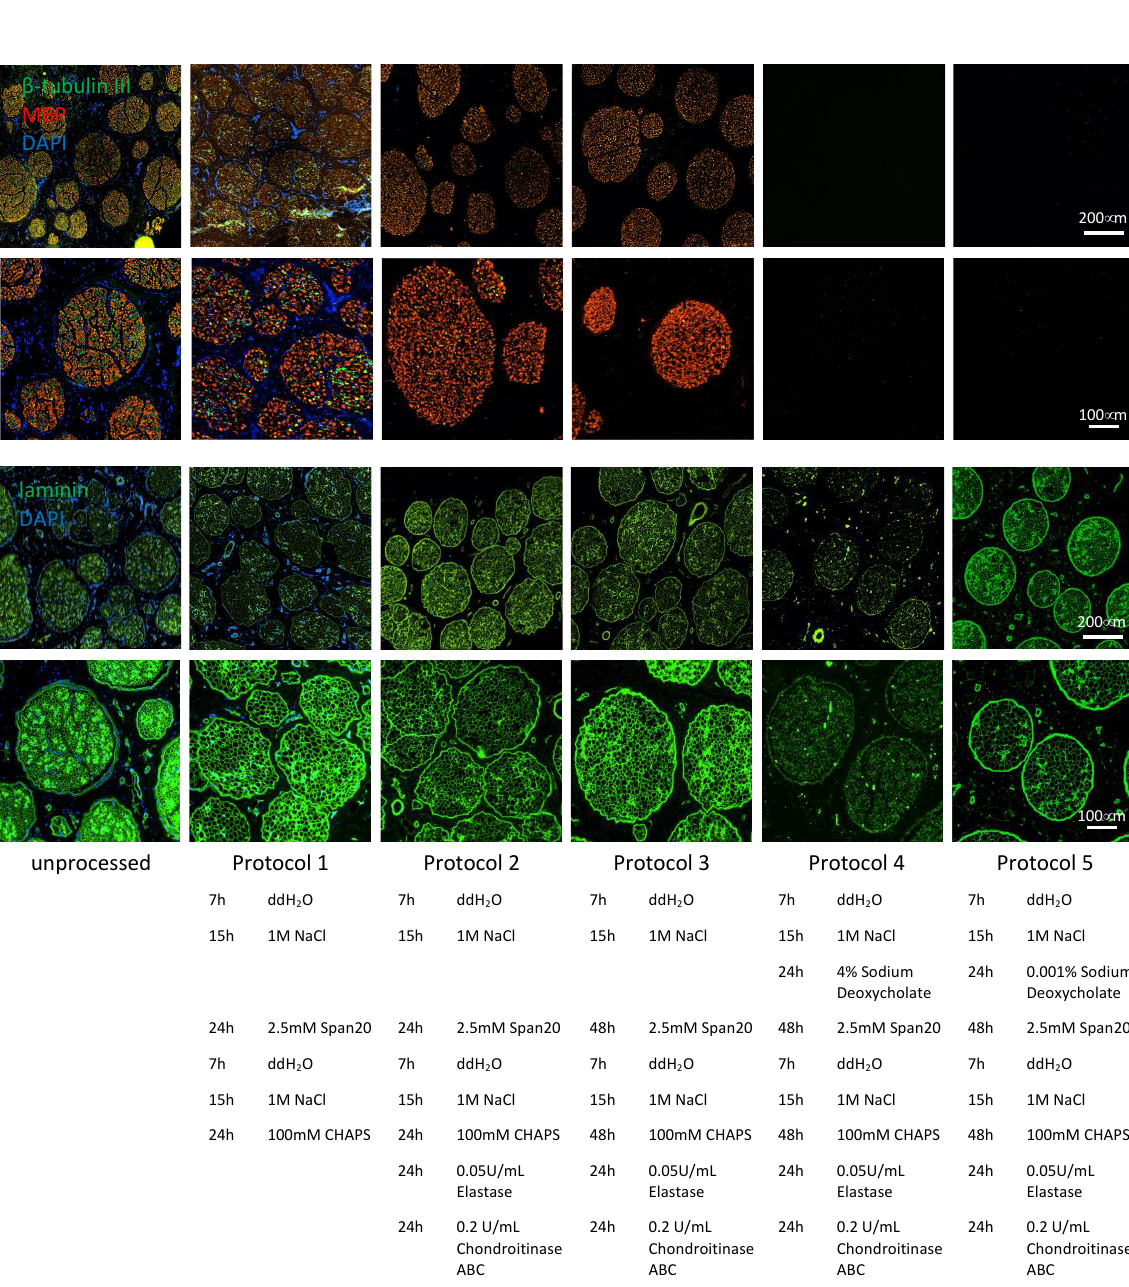
Figure 2. Removal of immunogenic material and ECM preservation by optimized protocols from large diameter pig nerves. First row: scale bar 200 µ m, representative images of remaining axonal β -tubulin III, MBP and DAPI. Second row: scale bar 100 µ m, zoomed-in representative images of remaining axonal β -tubulin III, MBP and DAPI. Third row: scale bar 200 µ m, representative images of remaining ECM laminin structure and DAPI. Fourth row: scale bar 100 µ m, zoomed-in representative images of remaining ECM laminin structure and DAPI. Each column shows a further optimization step towards protocol 5, an acellular graft with removed axonal β -tubulin III, MBP, DAPI and a conserved laminin structure signal. Protocol 5 was used for further analysis.